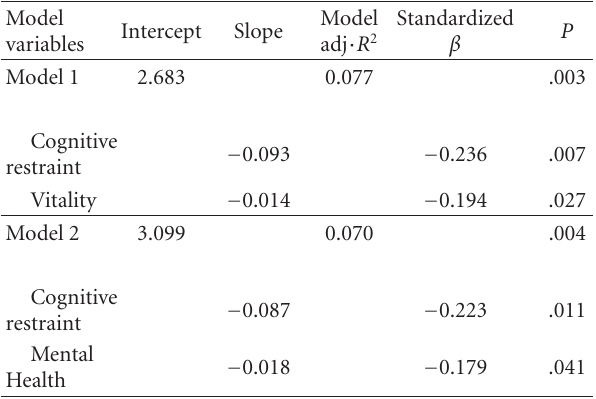
Table 3: Multiple linear regression models for the dependent variable “accuracy of perceived